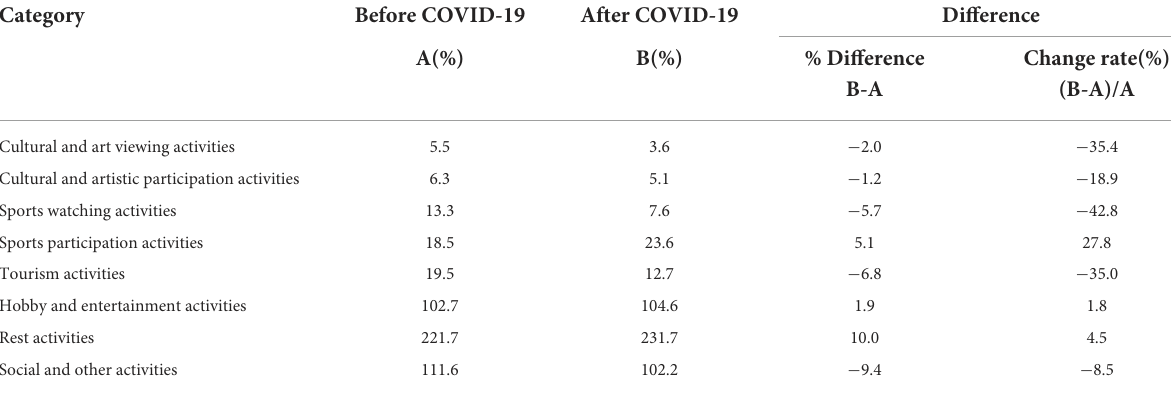
TABLE 2 Changes in leisure activities of the elderly after COVID-19: aspects of participation rate. Category